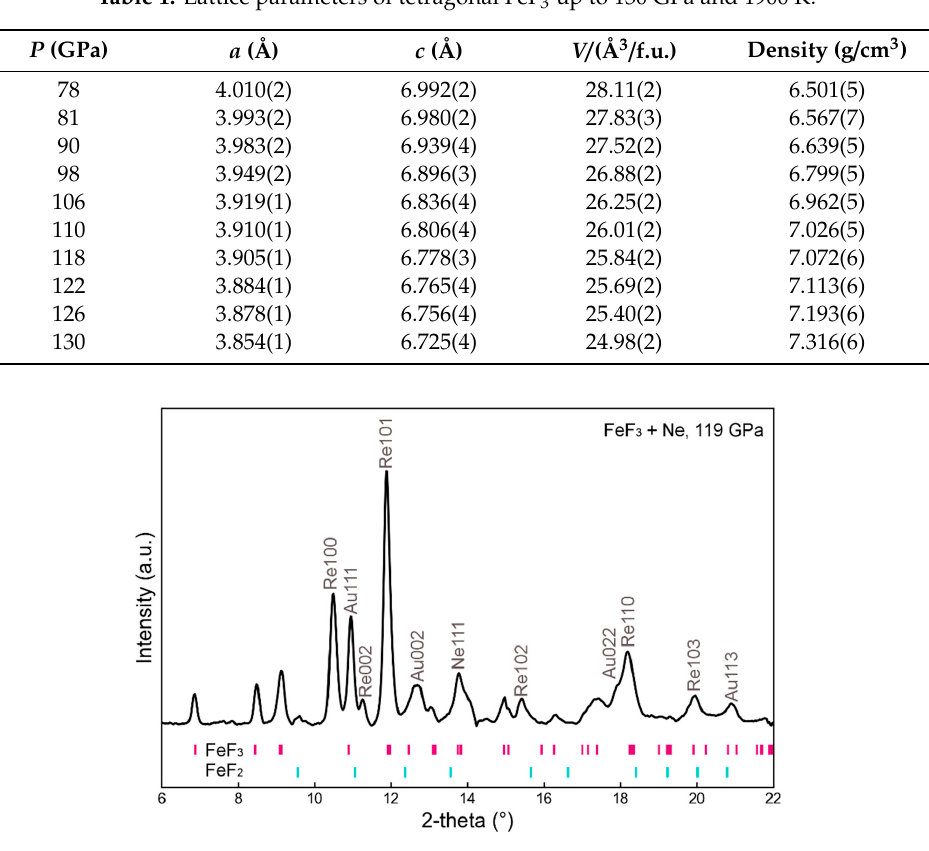
Figure 2. X-ray diffraction patterns at 119 GPa (Au pressure), 300 K after laser heating. At the center of the heated area, the majority of diffraction peaks (other than those from Au and Re) belong to the tetragonal P 4 2 2 1 2 phase of FeF 3 . A few minor peaks are consistent with the pyrite-type FeF 2 . Data were acquired using an X-ray wavelength of 0.4066 Å.